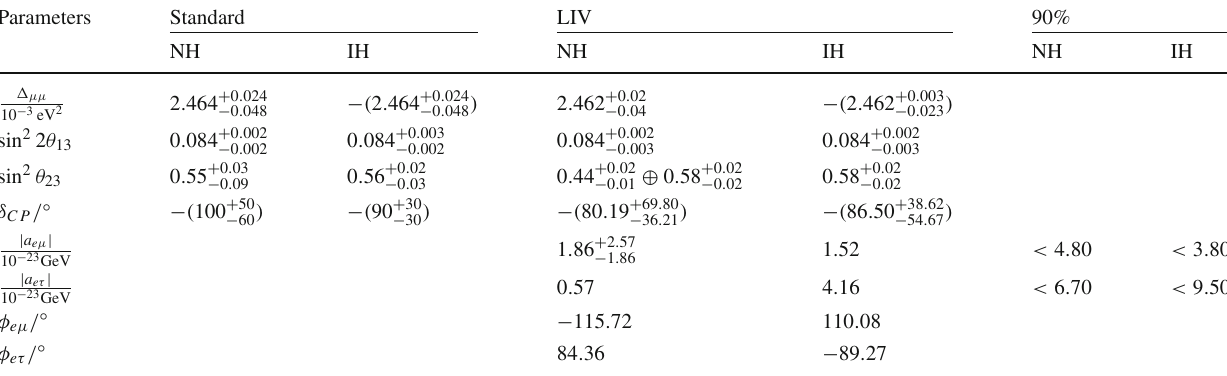
Table 4 Parameter values at the best-fit points for the combined analysis of NO ν A and T2K.The 1 σ error bars have been mentioned where possible. The 90% limits for 1 d.o.f have also been mentioned